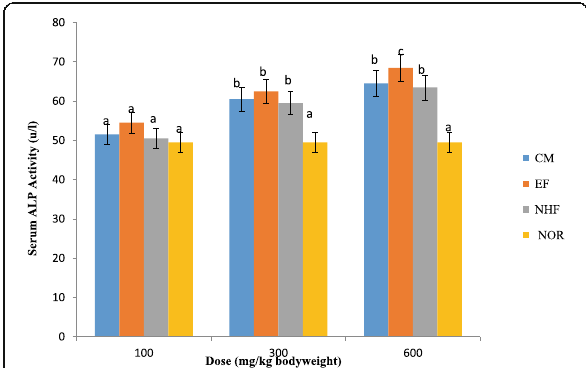
Fig. 3 Effect of crude extract and fractions of Gymnema sylvestre on serum alkaline phosphatase activities of rats. Mean with different superscripts differ significantly (p < 0.05). Key: NOR: normal control, CM: crude methanol extract, EF: ethyl acetate fraction, NHF: